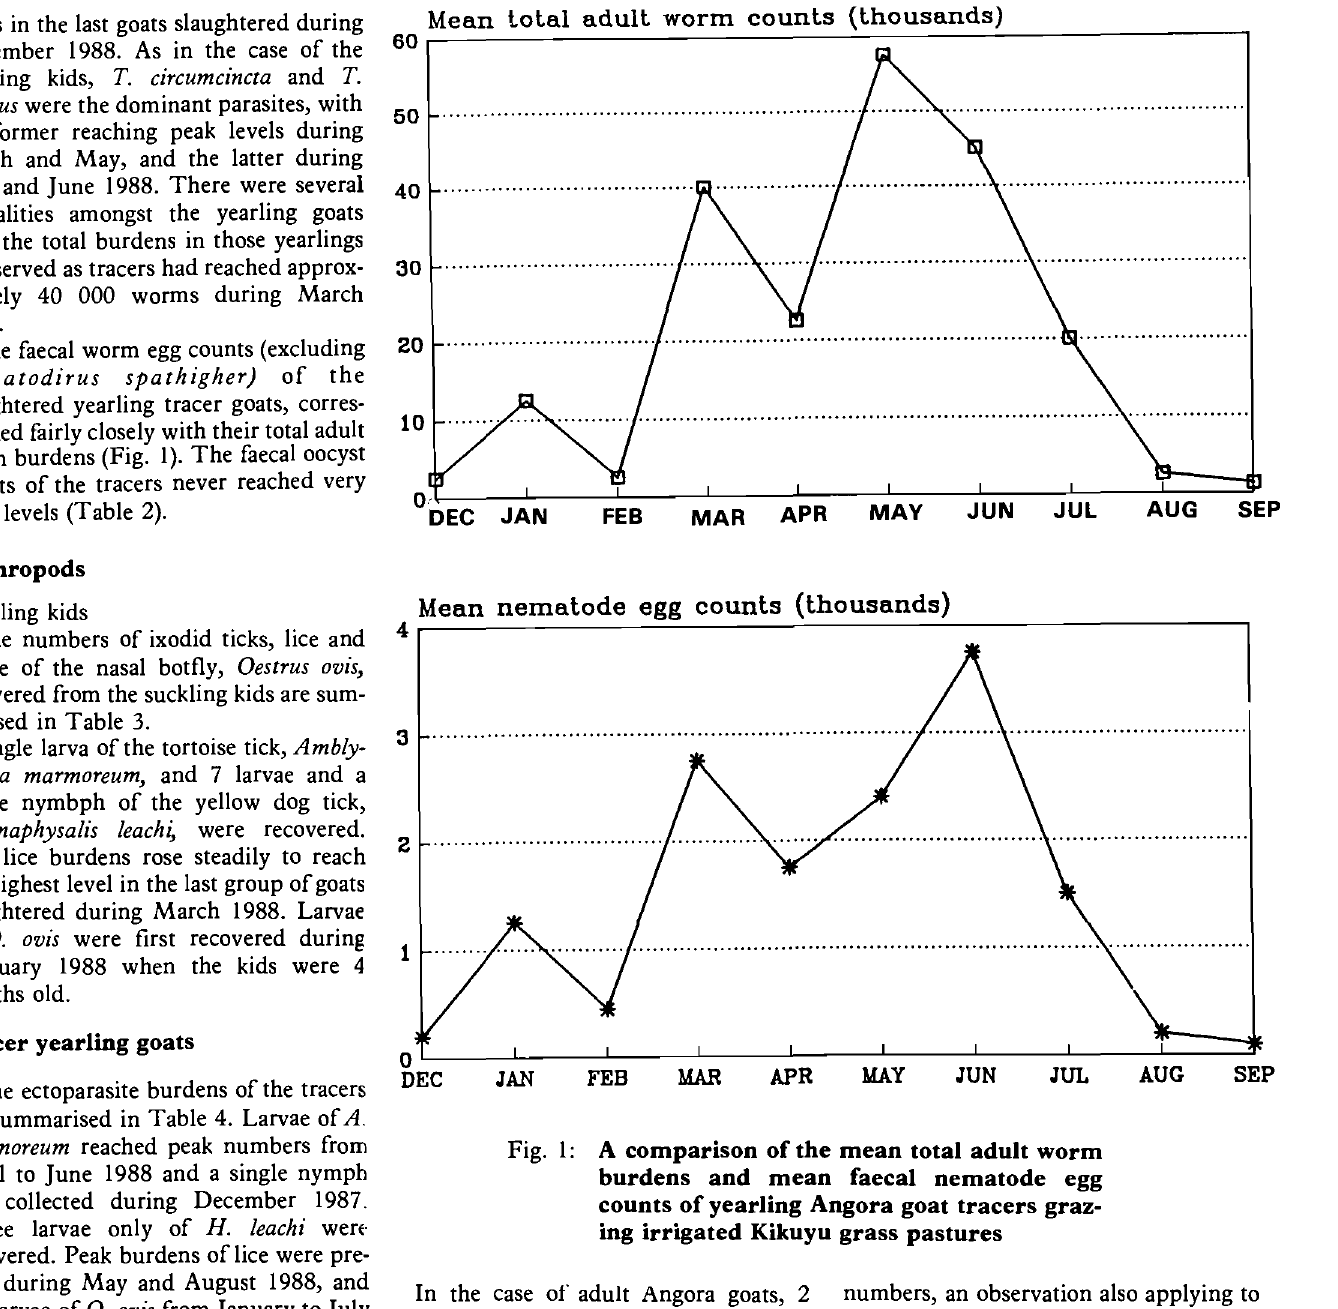
Fig. 1: A comparison of the mean total adult worm burdens and mean faecal nematode egg counts of yearling Angora goat tracers graz ing irrigated Kikuyu grass pastures numbers, an observation also applying to Angora goats and sheep running in Valley Bushveld on a nearby farm 7• One is left